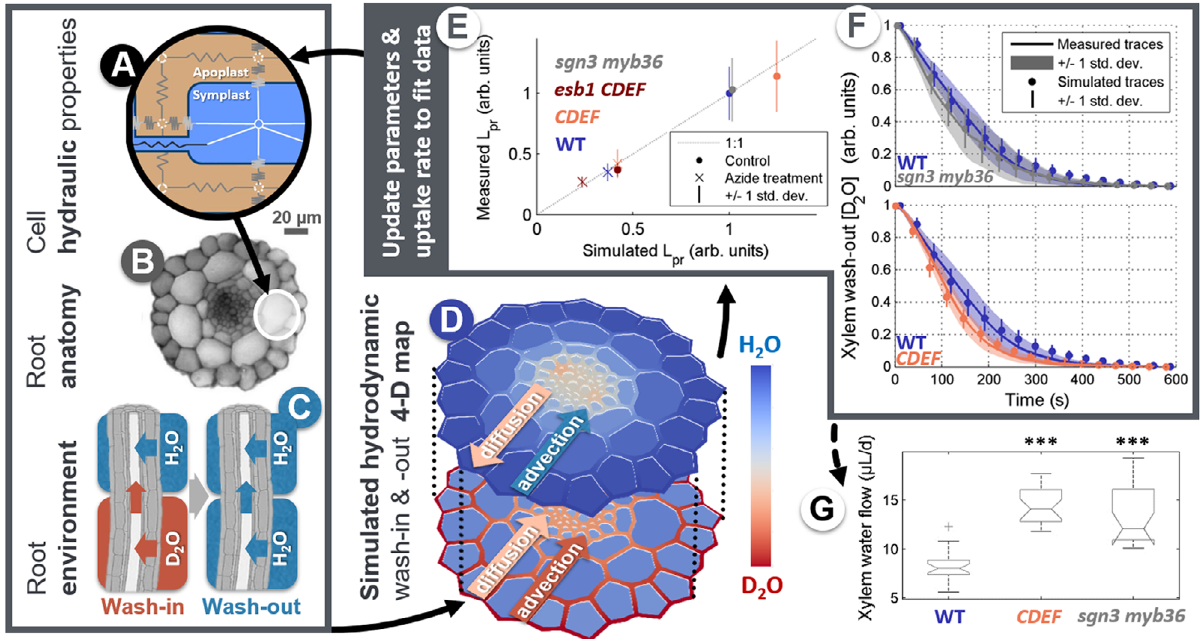
Fig. 2 Scheme of the inverse modeling loop used to extract quantitative xylem water fl ow rate data from RMS D2O wash-out traces. A Scheme of the subcellular compartments and pathways of the hydraulic model MECHA. B A. thaliana root anatomy used in the model. C Scheme of D 2 O wash-in and wash-out conditions. D Snapshot of a simulated D 2 O map for a mutant with no Casparian strip during the wash-in phase. E Fit of measured and simulated root hydraulic conductivities used to constrain the cell hydraulic parameters (WT: N = 15; CDEF : N = 12; esb1 CDEF : N = 10; sgn3 myb36 : N = 10 independent plants; vertical bars show the extent of one standard deviation on both sides of the mean values). F Fit of measured and simulated D 2 O wash-out traces (WT: N = 24; CDEF : N = 18; sgn3 myb36 : N = 9 independent plants; vertical bars and shaded areas show the extent of one standard deviation on both sides of the mean values). G Retrieved xylem water fl ow rates (WT: N = 24; CDEF : N = 18; sgn3 myb36 : N = 9 independent plants; boxplots show 25th, 50th, and 75th percentiles, whiskers the most extreme points excluding outliers “ + ” ). Triple stars indicate Anova-1 p- values below 0.001. Source data underlying Fig. 2E – G are provided as a Source Data fi Line scanning (Fig. 1) . Raman spectra were measured at different positions inside the plant by raster-scanning the root across the diffraction-limited laser focus in 2µm steps (equivalent to a line of 60 points). This process was repeated 60 times (across the same line) in order to capture the temporal evolution of D 2 O during the wash-in and wash-out processes. The acquisition time at each position was 300ms, yielding a total measurement time of approximately 32min (includes raster scanning overhead). The